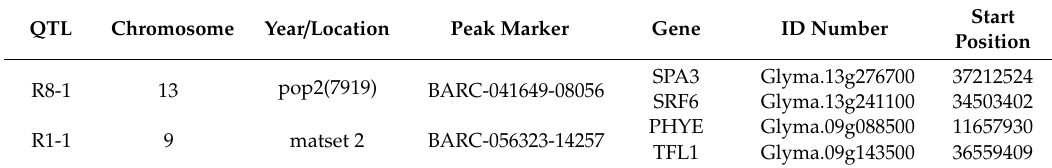
Table 4. Flowering-related genes in the vicinity of the QTL identified in this study.